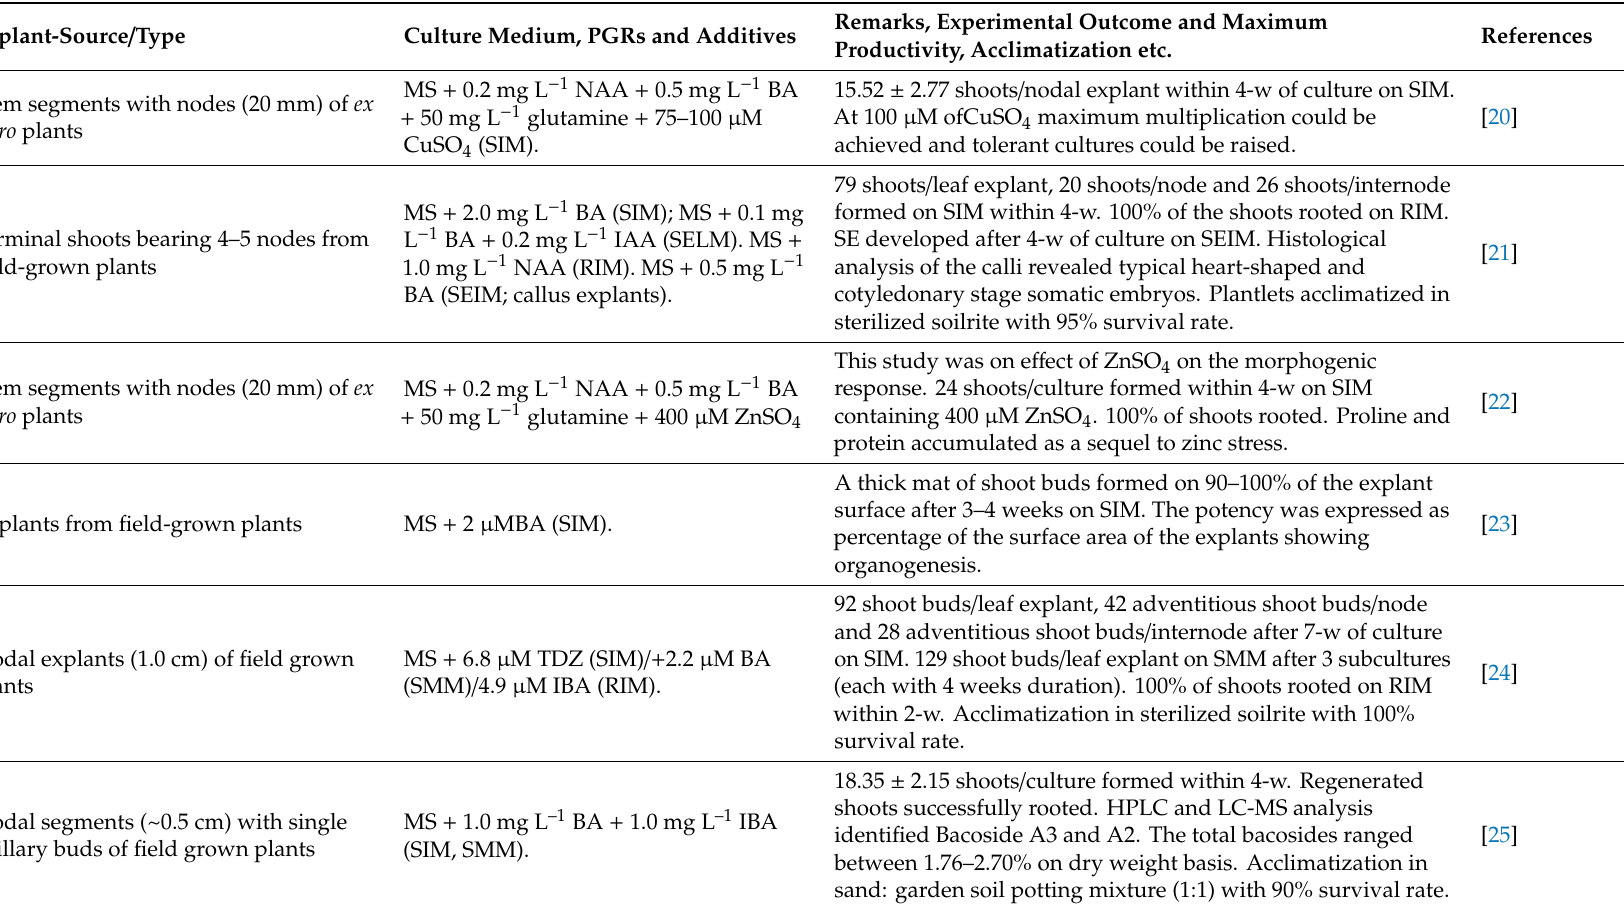
Table 1. In vitro propagation of Bacopa monnieri (L.) Wettst. (Chronological